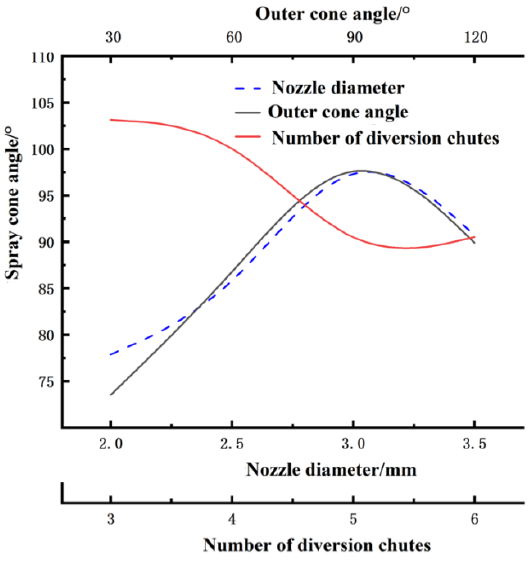
Figure 6. The influence of key structures on the spray cone